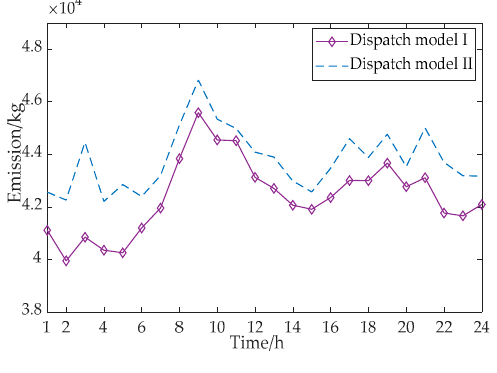
Figure 14. The emission of CO 2 .